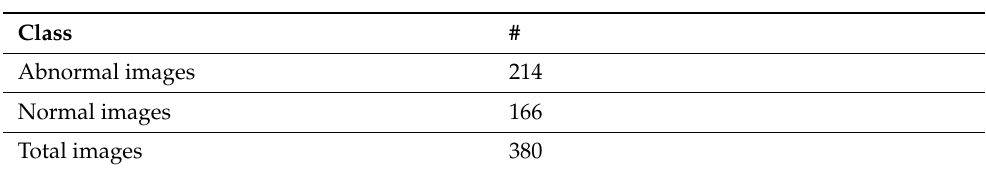
Table 5. Dataset-II